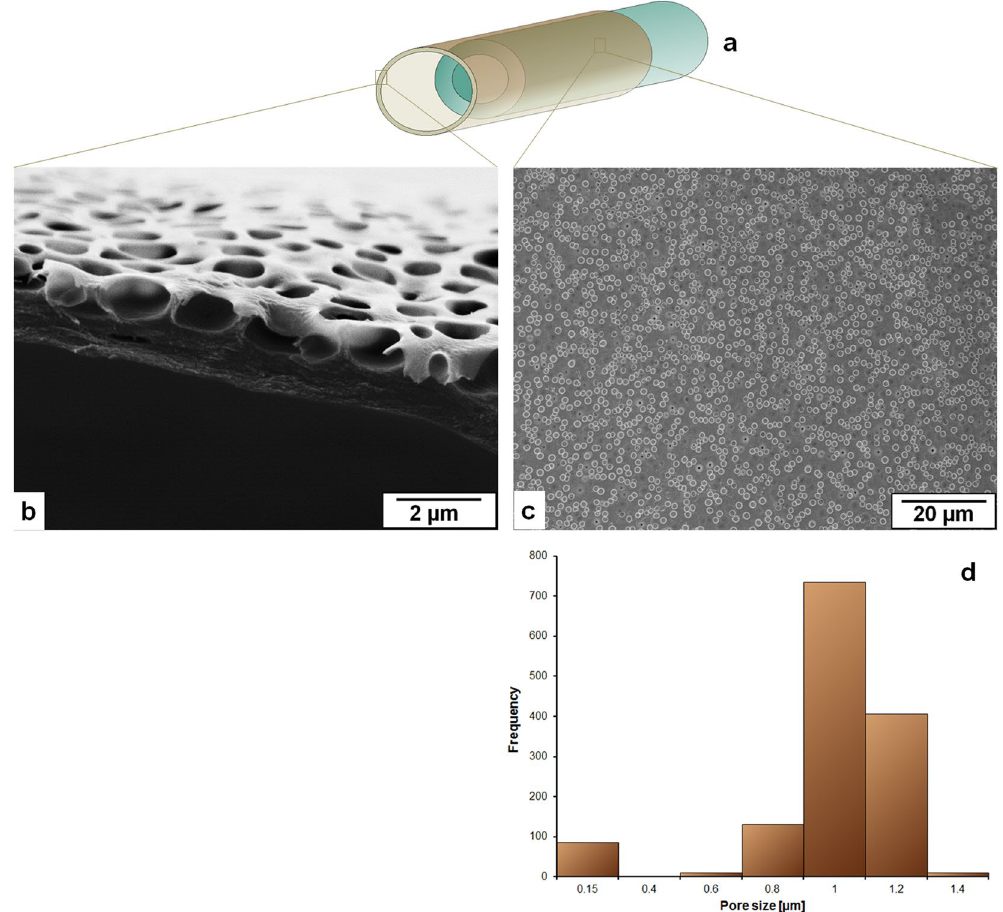
Figure 3. Film forming solution: 12% CA in 1,4-dioxane (Group 2 in Table 1); ( a ) A schematically drawn double layer hollow fiber where the macroporous outer layer encircles the support layer hollow fiber, ( b ) Cross sectional view of the porous film under scanning electron microscope (SEM), ( c ) Surface of the film under SEM, ( d ) pore size distribution [1384 number of pores in 10.04 × 10 3 µ m 2 of the measured area] of the surface of the film forming layer measured by IMS V15Q4 (Imagic Bildverarbeitung AG, Glattbrugg,